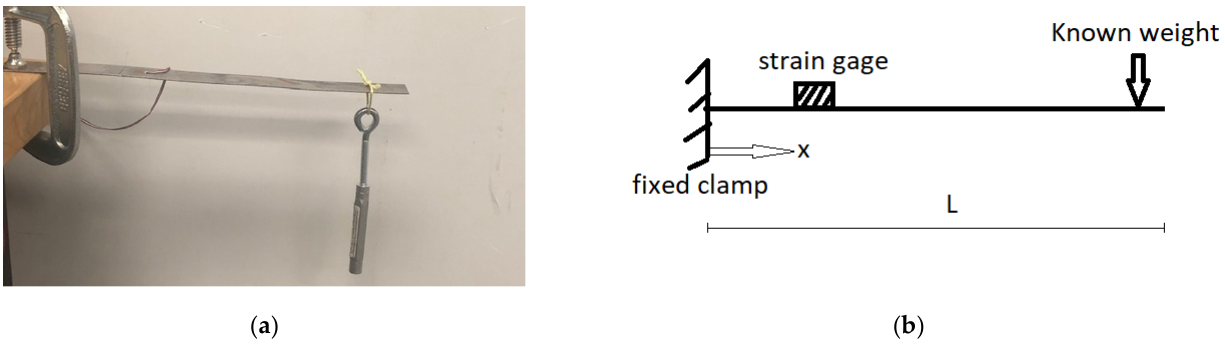
Figure 6. Static strain verification test set up. ( a ) Physical set up. ( b ) Schematic. Table 1. Properties for static strain verification.